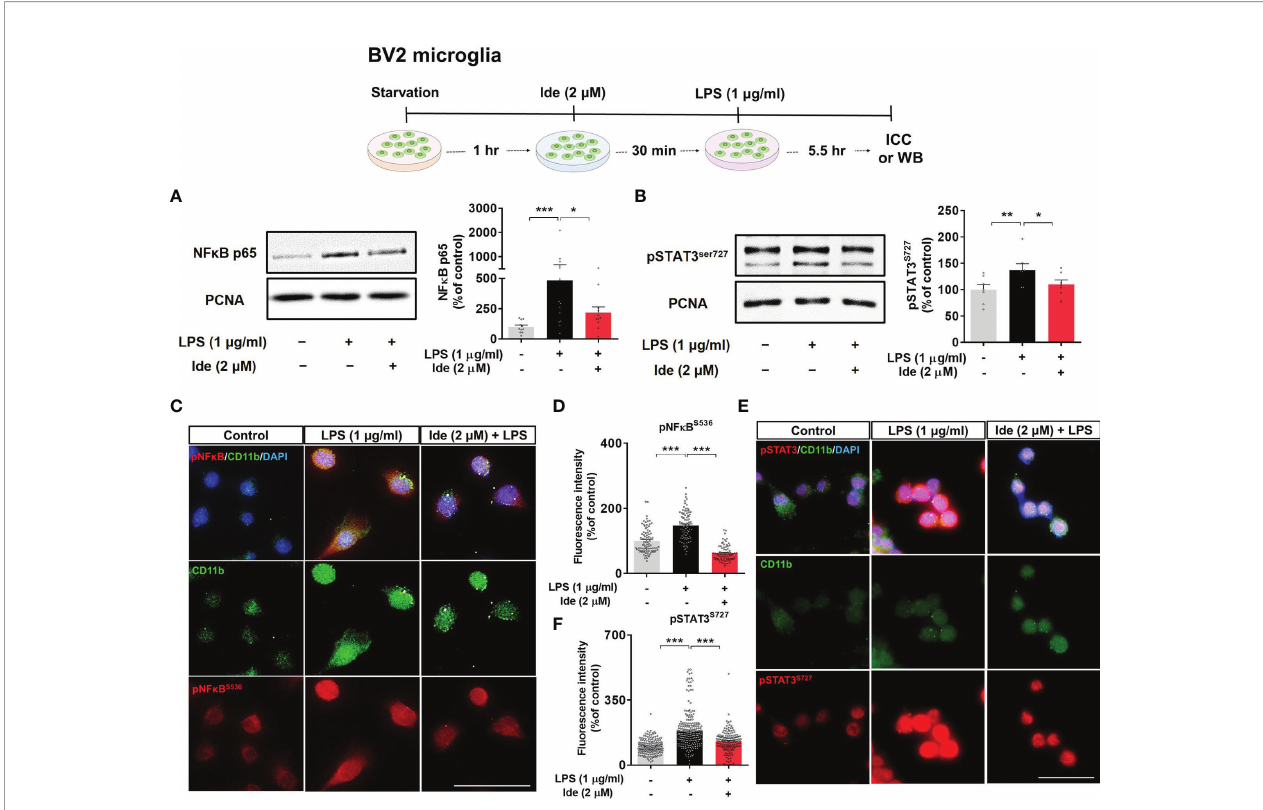
FIGURE 7 | Idebenone downregulates LPS-induced NF-kB and STAT3 signaling in BV2 microglial cells. Cells pretreated with idebenone (2 m M) or vehicle (1% DMSO) for 30 min were treated with LPS (1 m g/ml) or PBS for 5.5 h, and western blotting and immunocytochemistry were performed. (A) Representative immunoblots and quanti fi cation of nuclear NF-kB-p65 levels (n = 11/group). (B) Representative immunoblots and quanti fi cation of nuclear p-STAT3 levels (n = 7/ group). (C – F) Representative immunocytochemistry image and quanti fi cation of p-NF-kB S536 and p-STAT3 S727 expression (Veh, n = 89; LPS, n = 83; and Ide + LPS, n = 76 for p-NF-kB S536 and Veh, n = 180; LPS, n = 253; and Ide + LPS, n = 158 for p-STAT3 S727 ). *p < 0.05, **p < 0.01, and ***p < 0.001. Scale bar = 50 m